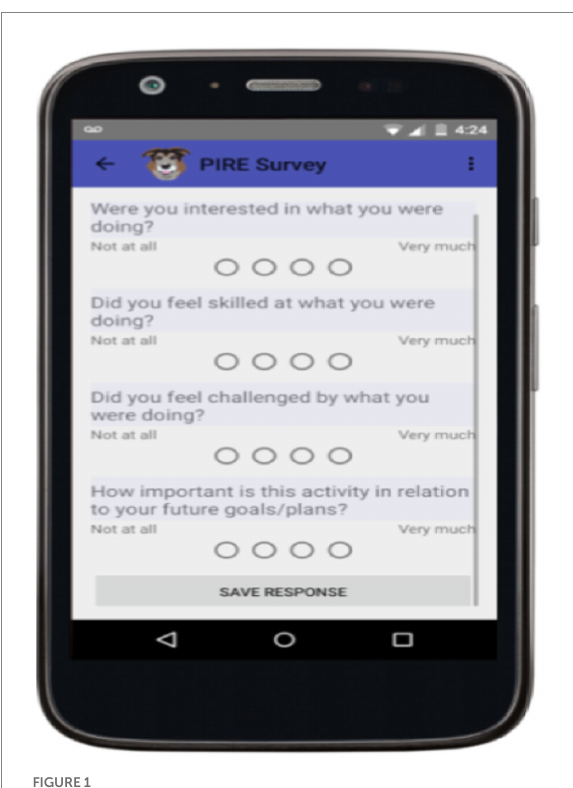
FIGURE 1 Screen shot of PACO app (Evans, 2016). Republished with